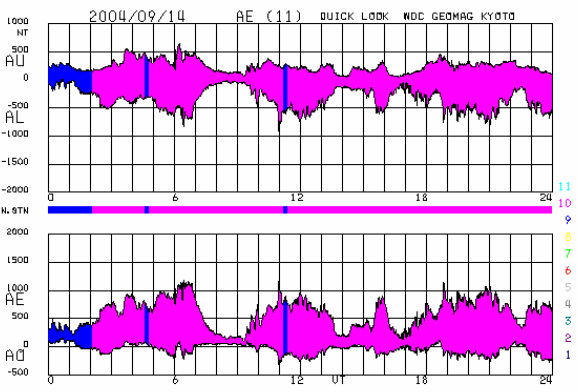
Fig. 15. The minute-averaged high energy proton flux in energy channels P1, P2 and P4 on 11 September